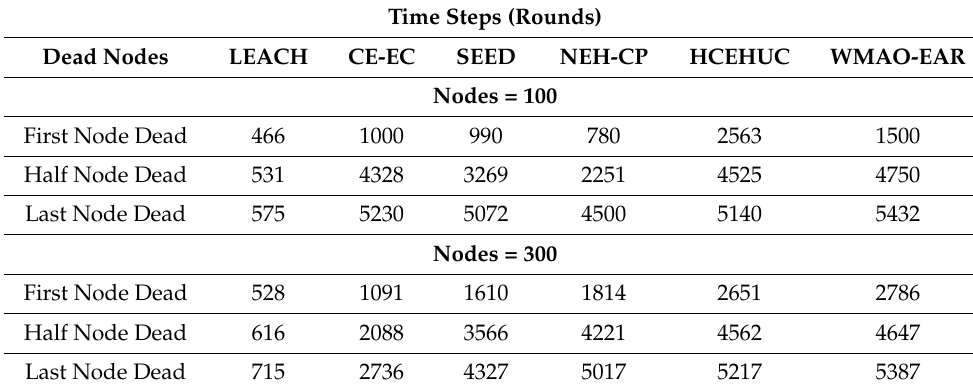
Table 1. Lifetime analysis of WMAO-EAR approach with existing algorithms under NC of 100 and